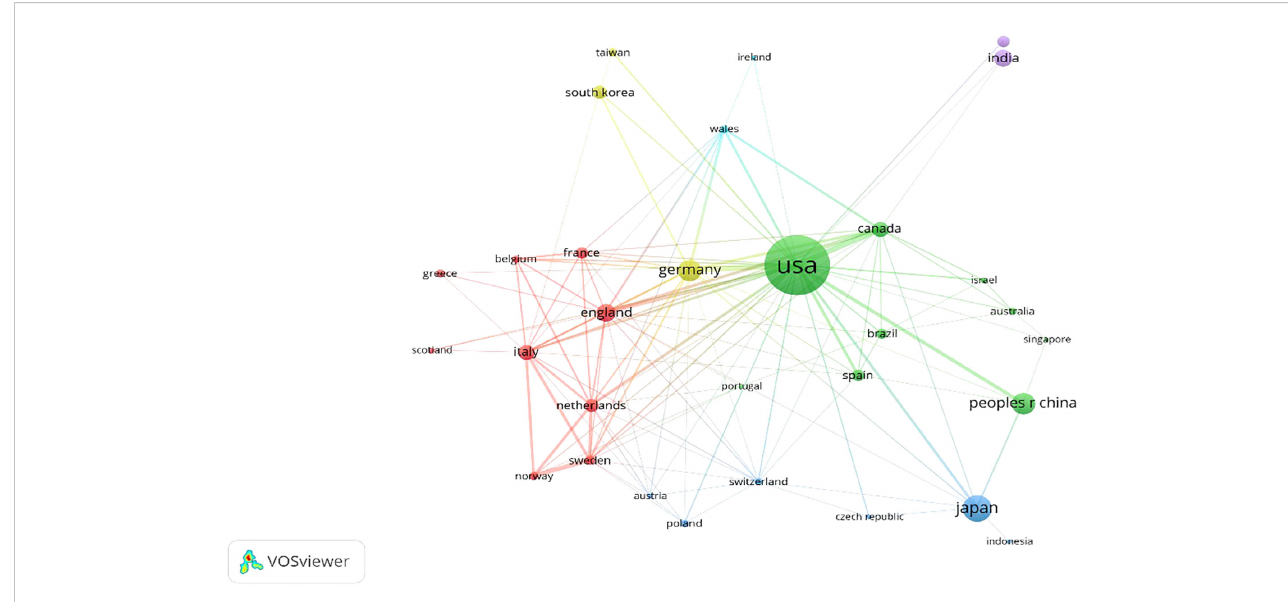
FIGURE 4 International collaboration network map. The widths of the connection lines indicate the collaboration strength. Countries with similar colors form a cluster VOSviewer.